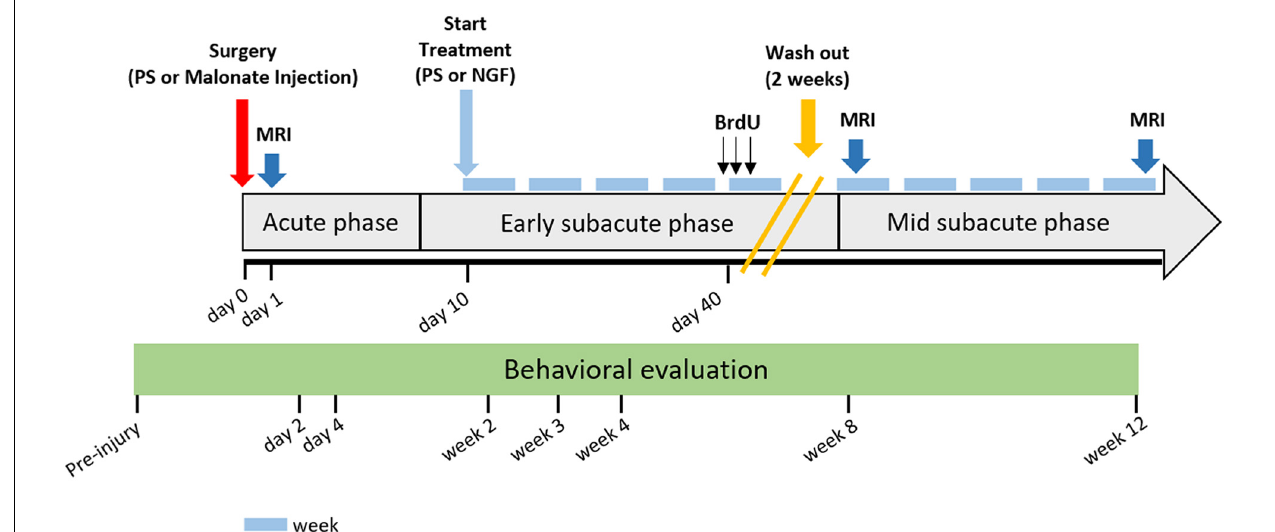
FIGURE 2 | Detailed study protocol. Behavioral tests started before injury and were performed at time points: day 2 and 4, and week 2, 3, 4, 8, and 12 post-injury. Intranasal administration of PS (vehicle) or NGF started at day 10 post-injury and lasted for 10 weeks (5 weeks + 5 weeks with 2 weeks of wash-out). MRI acquisitions were performed at day 1- and 8-weeks or 12-weeks post-injury. The gray arrow indicates stroke evolution: acute phase until day 7, early subacute phase from day 7 to week 8 post-injury; mid subacute phase from week 8 to 12 post-injury. Each light blue-dash indicates one week. Yellow oblique-parallel lines on the gray arrow indicate the wash-out period. PS: physiological saline; NGF: nerve growth factor; MRI: magnetic resonance imaging; BrdU: 5 (cid:48)